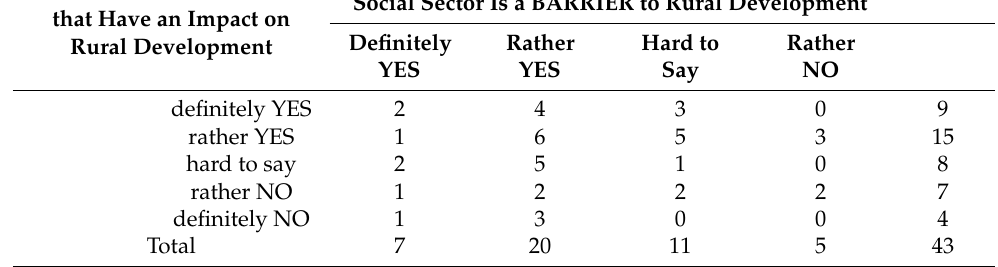
Table 4. Opinion of those recognizing the IMPACT of associations on rural development, on the low interest in cooperation with science by the social sector.